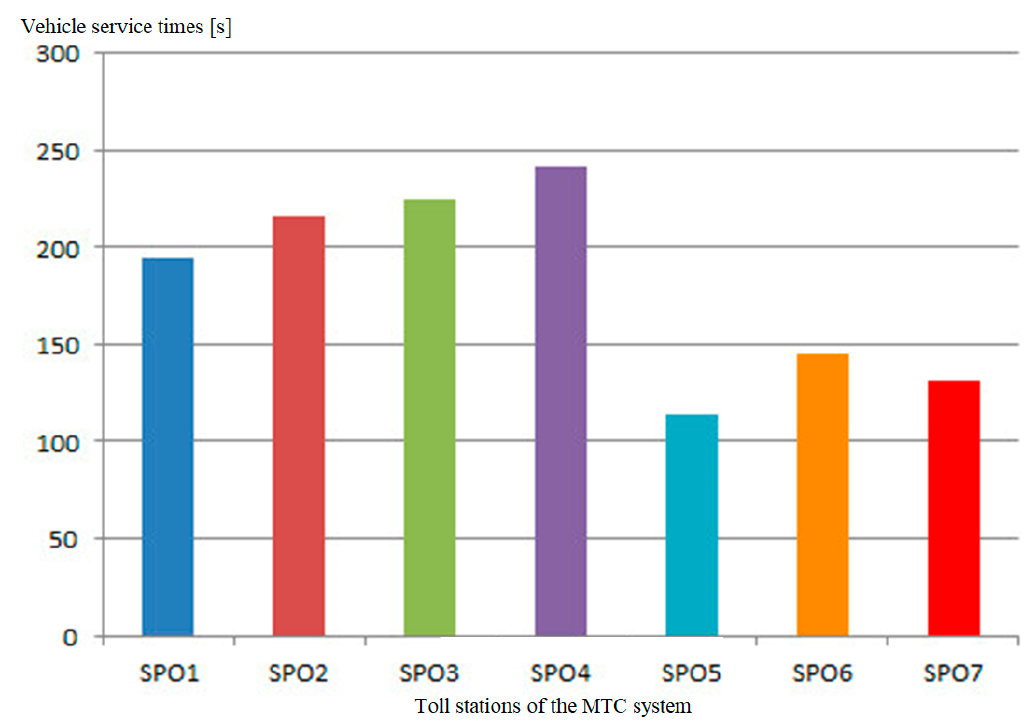
Figure 5. Distribution of vehicle service times at individual toll stations of the MTC system. Source: own study.